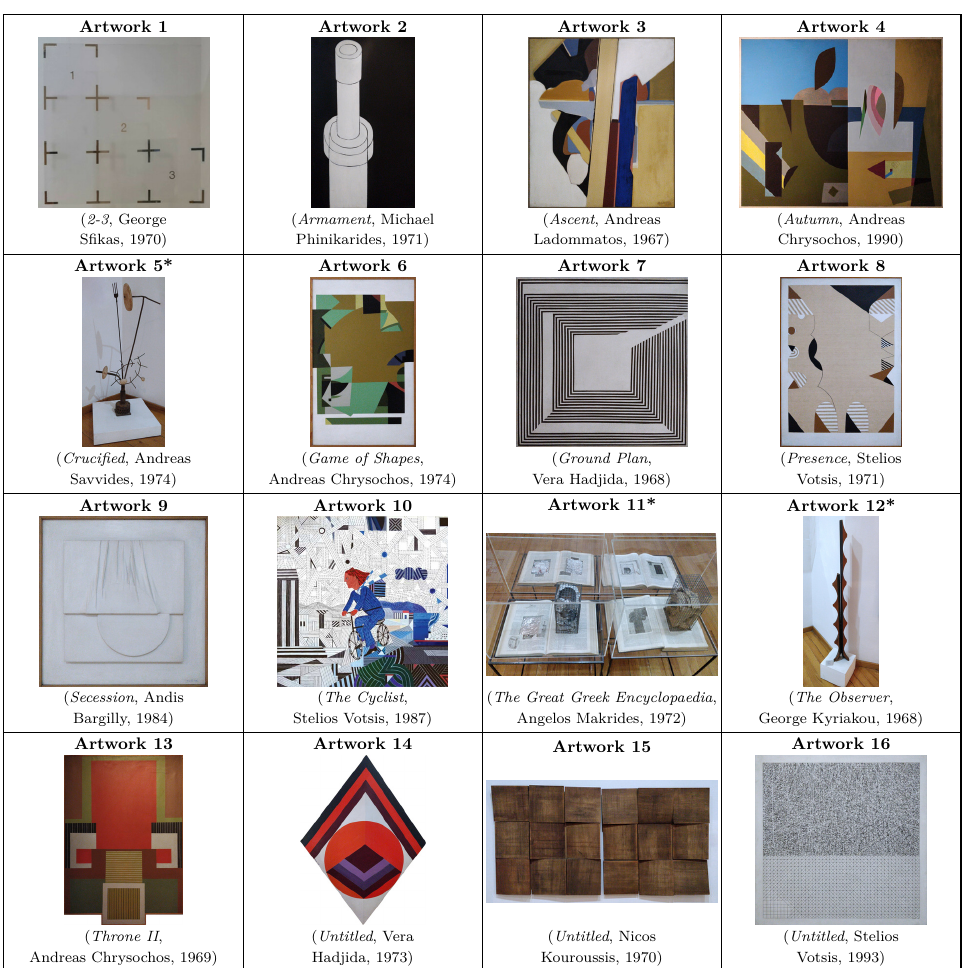
Figure 5. The artworks used in the experimental setup (artworks marked with an * are 3D